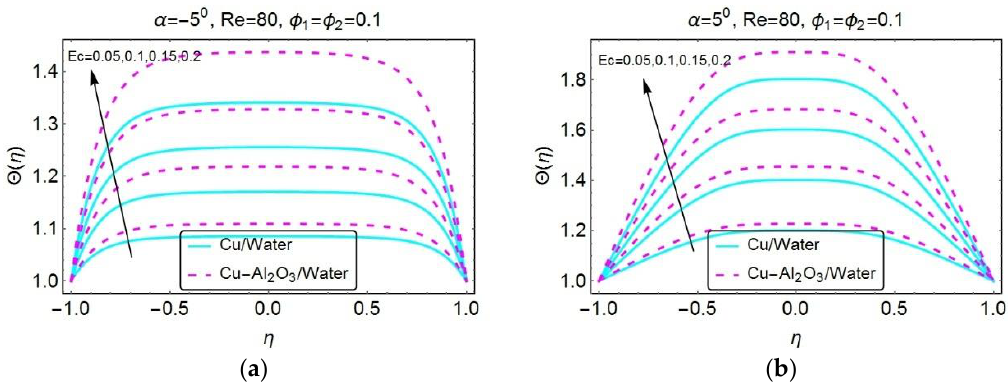
Figure 8. Stimulus of Ec on Θ(η) : ( a ) convergent case and ( b ) divergent channel.